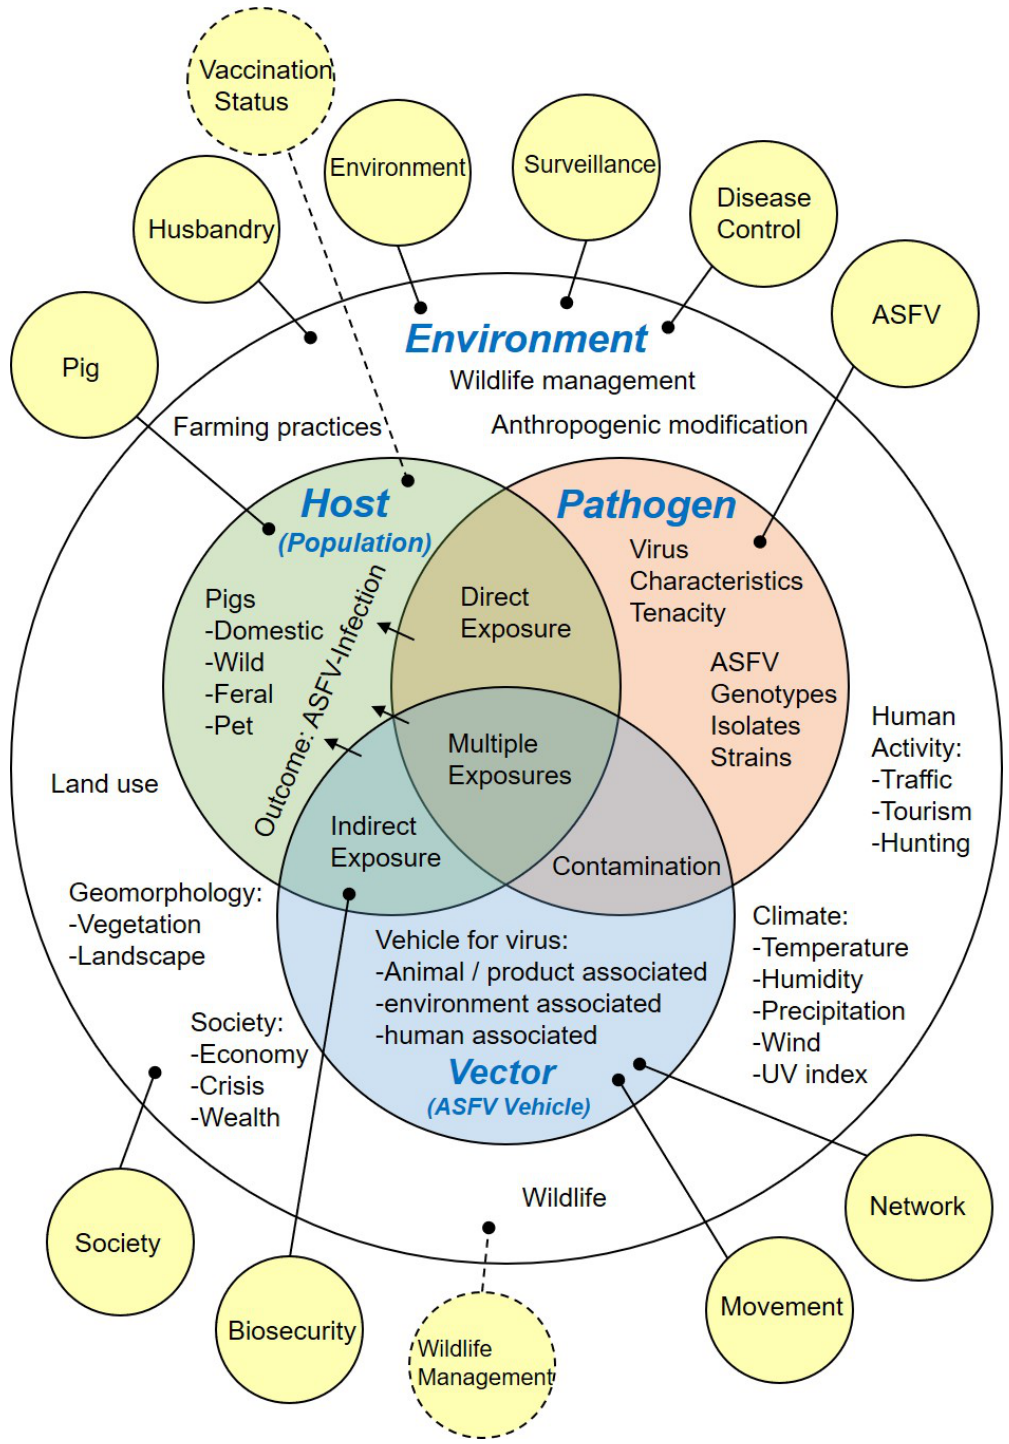
Figure 3. Epidemiological triad modified to structure possible disease determinants relevant for ASF occurrence (Environment, Host, Pathogen, Vector). Solid yellow bubbles indicate observation-based risk categories, while dashed yellow bubbles indicate additional potential risk factor categories. ASFV, African swine fever virus; UV, ultra violet. A description of each risk category is presented in Table